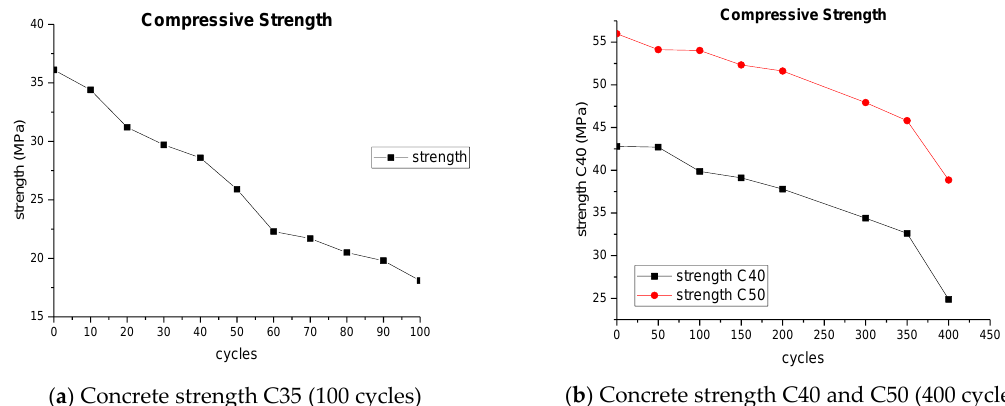
Figure 7. Compressive strength changes of concrete samples in association with freeze–thaw cycles.